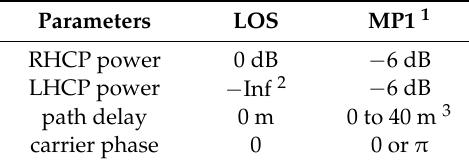
Table 3. The parameters of the one LOS and one reflected path signals.